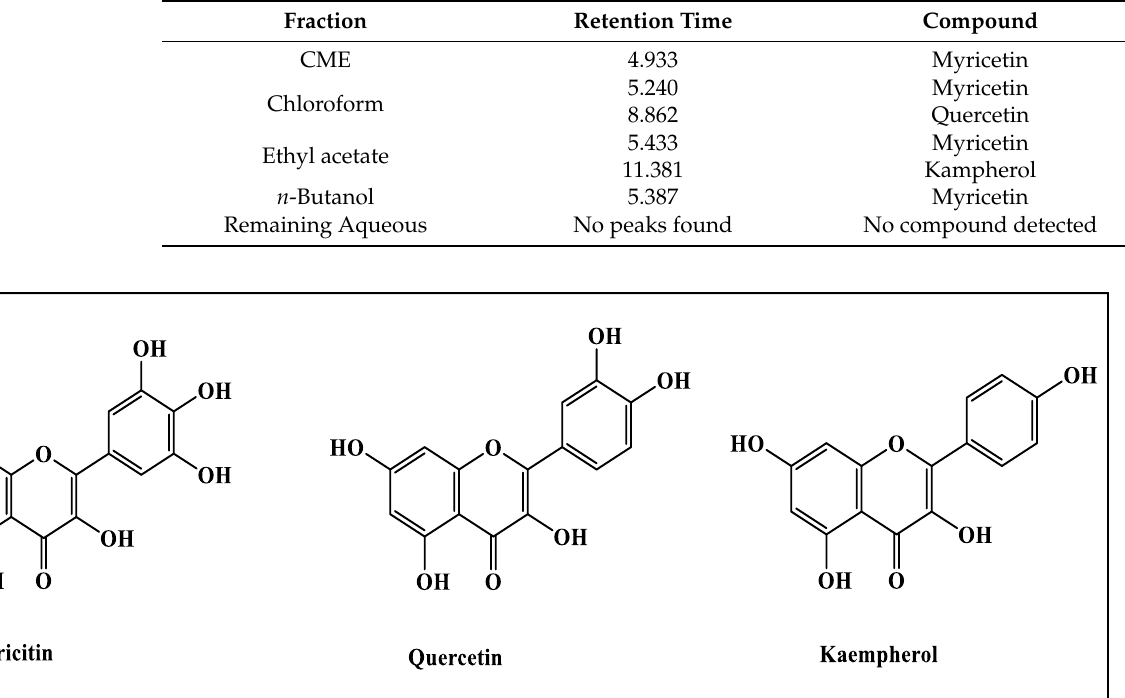
Figure 1. Compounds identified in H. crispum total methanol extract (CME) as well as its various fractions using HPLC. fractions using